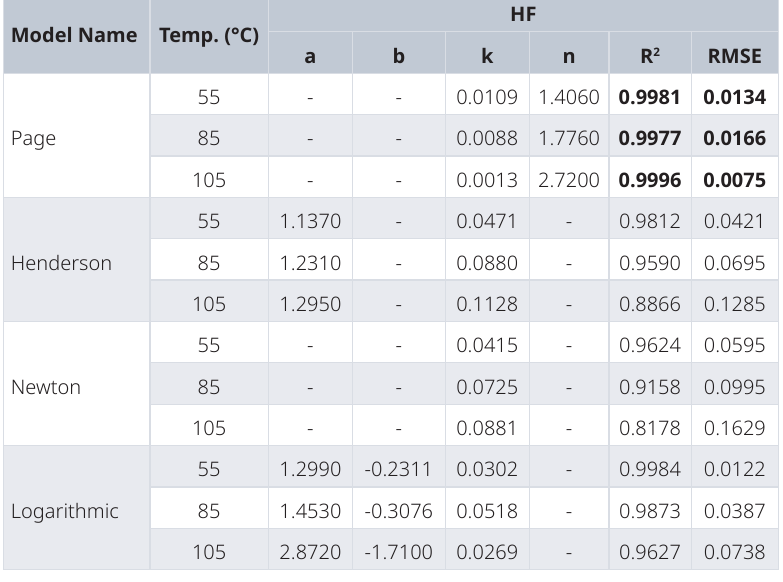
Model Name Temp.